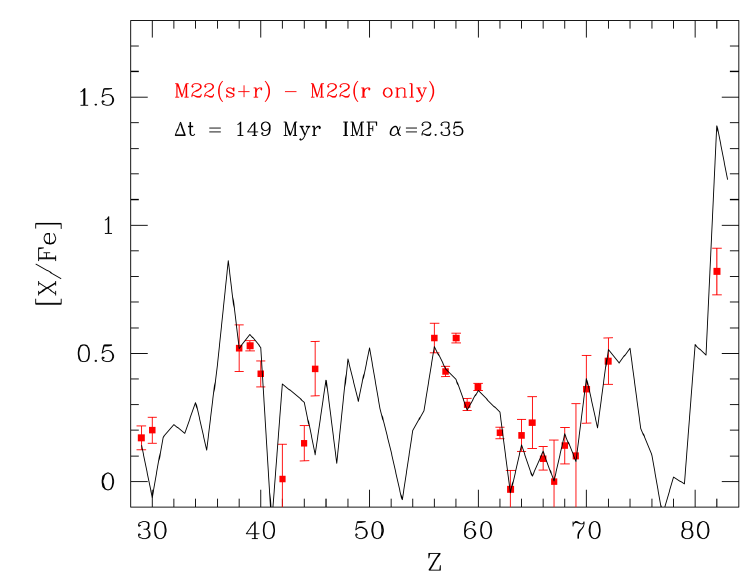
Figure 1. Average abundances observed in the globular cluster M22 (red points) compared to the theoretical expectations deduced from stellar models (from